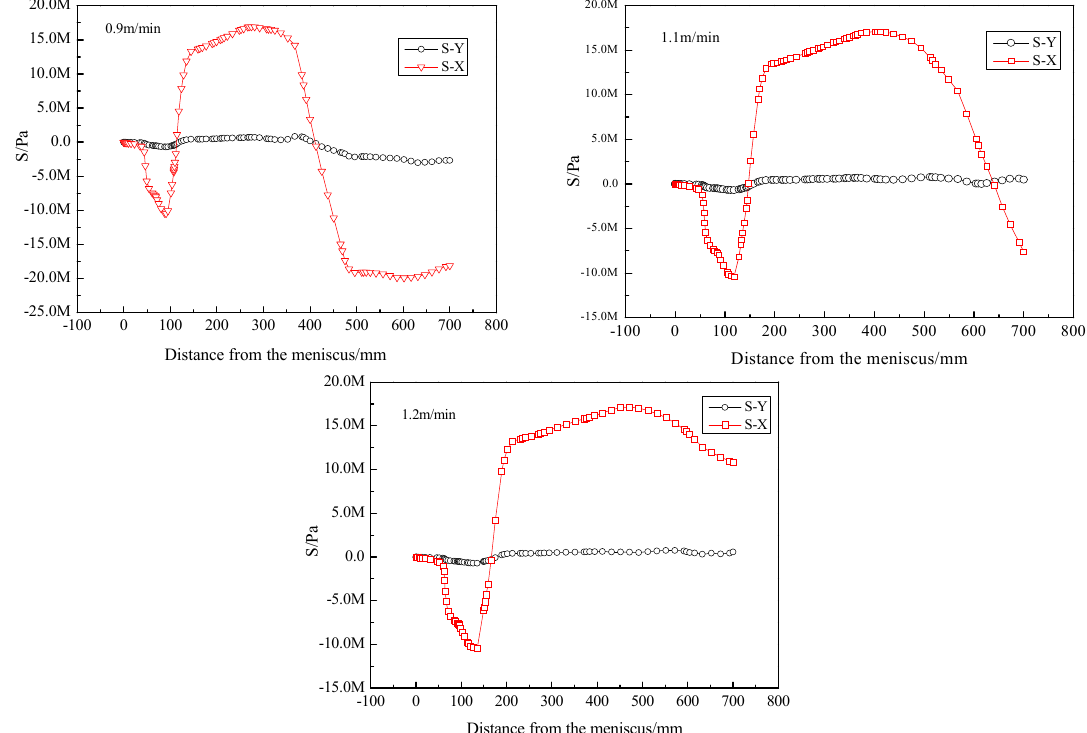
Figure 14. Stress at the center of the web at different casting speeds.